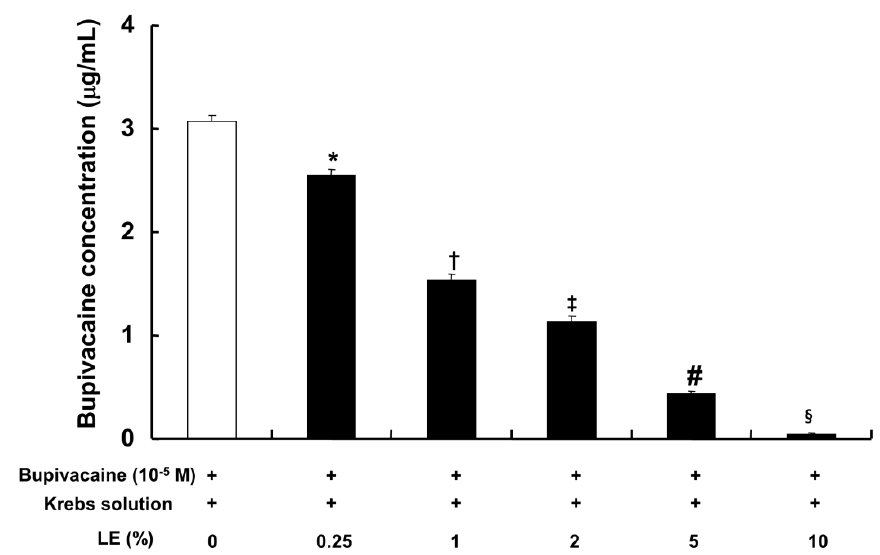
Figure 6. Effect of lipid emulsion (LE) on bupivacaine (10 −5 M) in Krebs solution. After removal of the emulsified bupivacaine and lipid, the remaining bupivacaine in the centrifuged aqueous extract was measured by ultraperformance liquid chromatography-quadrupole time-of-flight mass spectrometry in the multiple reaction monitoring mode. Data ( n = 5) are expressed as the mean ± SD. Data were analyzed by one-way analysis of variance (ANOVA) with Duncan’s test using SPSS 17.0 (SPSS Inc., Chicago, IL, USA). n indicates the number of independent experiments. * p < 0.001 versus bupivacaine alone, † p < 0.001 versus bupivacaine + LE (0.25%), ‡ p < 0.001 versus bupivacaine + LE (1%), # p < 0.001 versus bupivacaine + LE (2%), § p < 0.001 versus bupivacaine + LE (5%). Bupivacaine (10 − 5 M) significantly enhanced the PKC phosphorylation evoked by